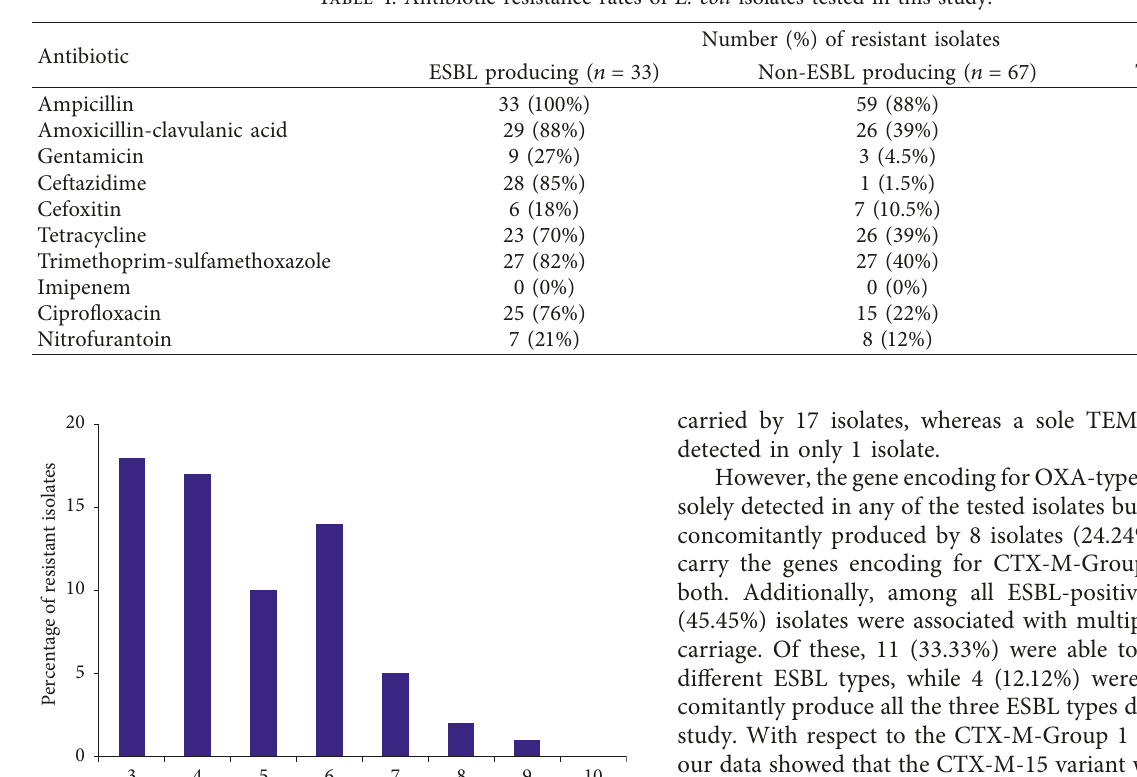
Table 4: Antibiotic resistance rates of E. coli isolates tested in this